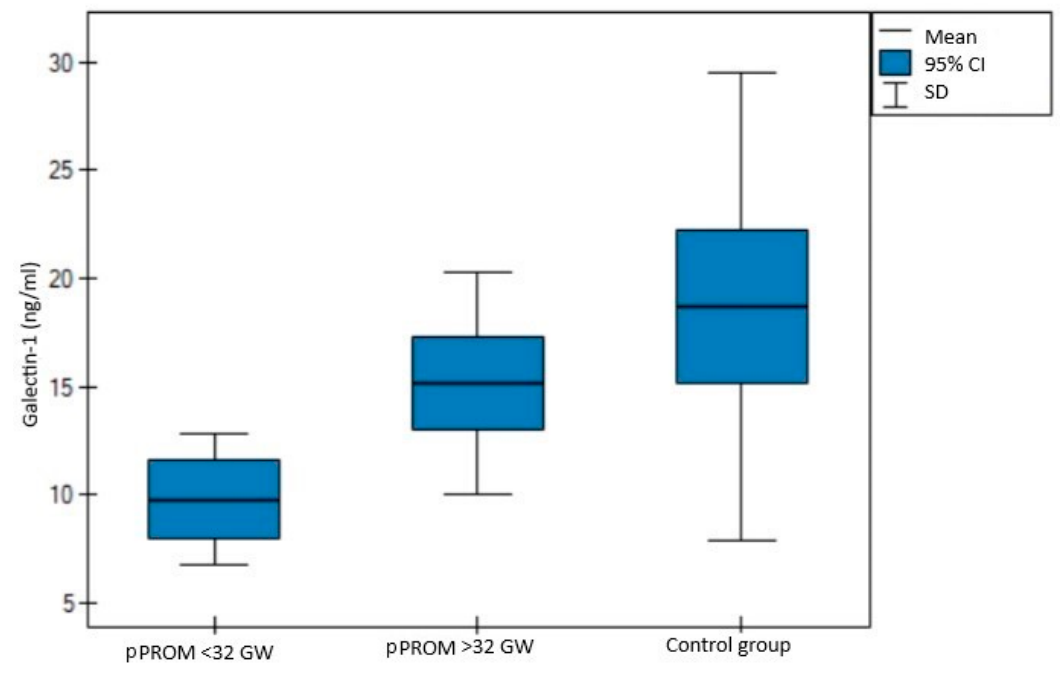
Figure 3. Comparison of three independent groups for galectin-1.